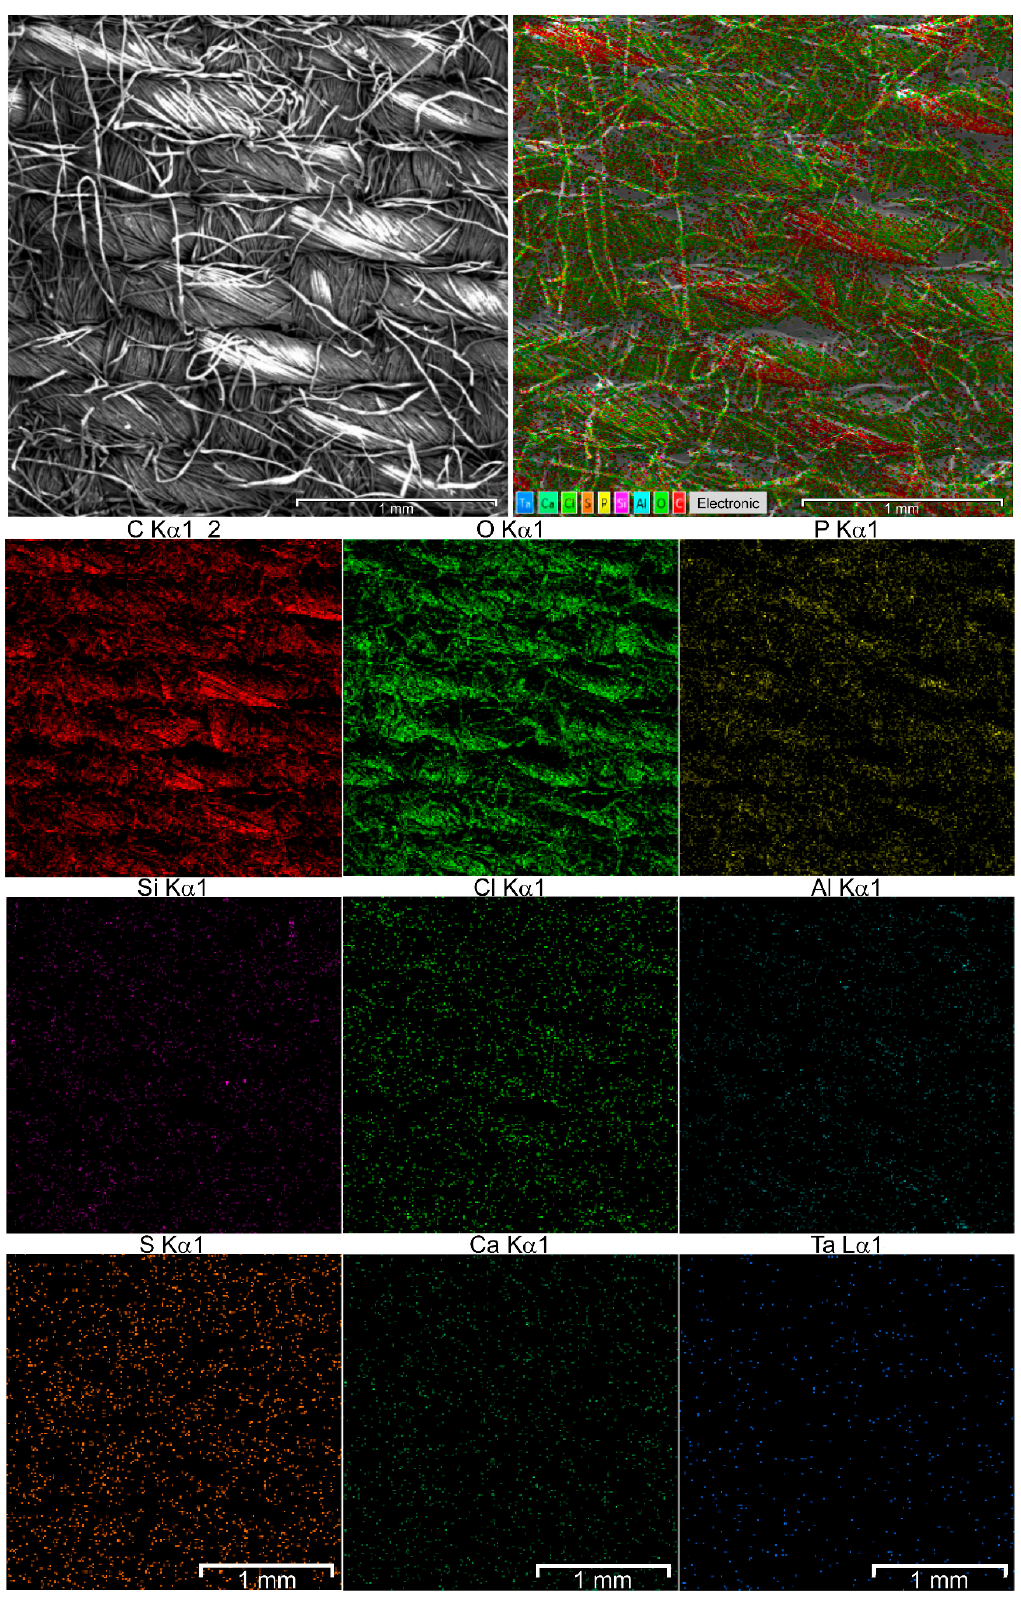
Figure 2. SEM and composite elemental images of fibrous material after deposition of Ta EtOH nanoparticles. Elementwise chemical analysis is shown on inserts.